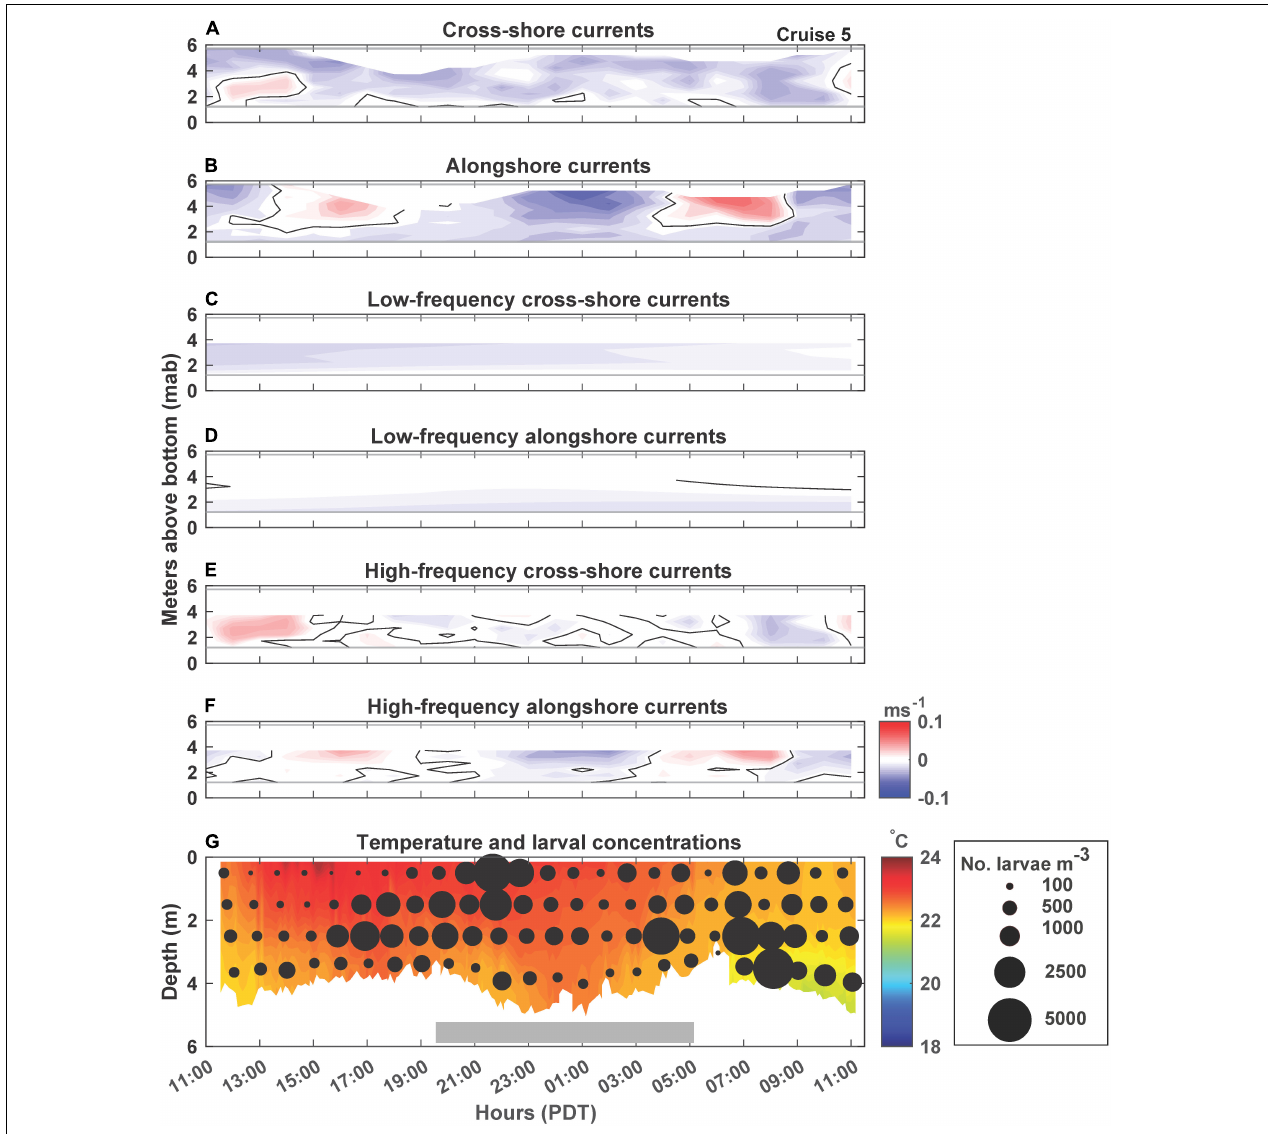
FIGURE 6 | Cruise 5 (July 16–17, 2018) currents, temperature and larval concentrations. Figure details are the same as Figure 2 . Note that C. fissus larval concentration circles are scaled differently than for Cruises 1, 2, and 4 due to high larval